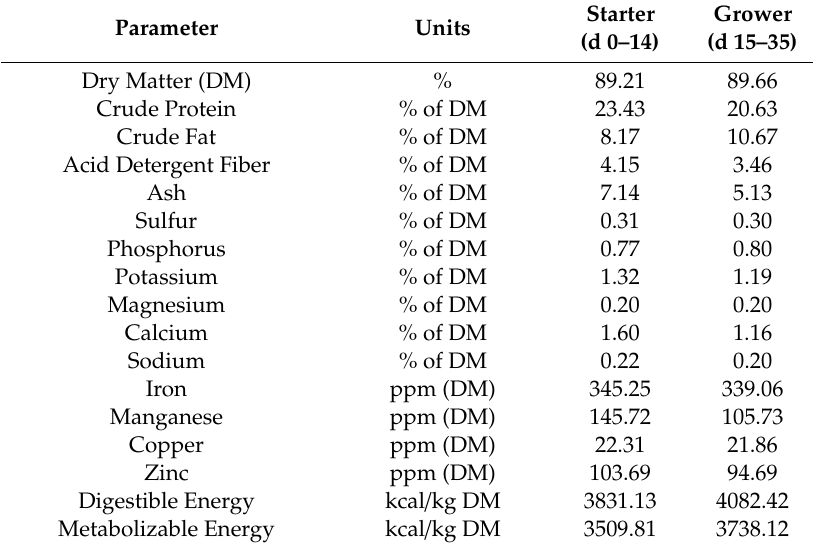
Table 2. Nutrient composition of basal diets for each growing